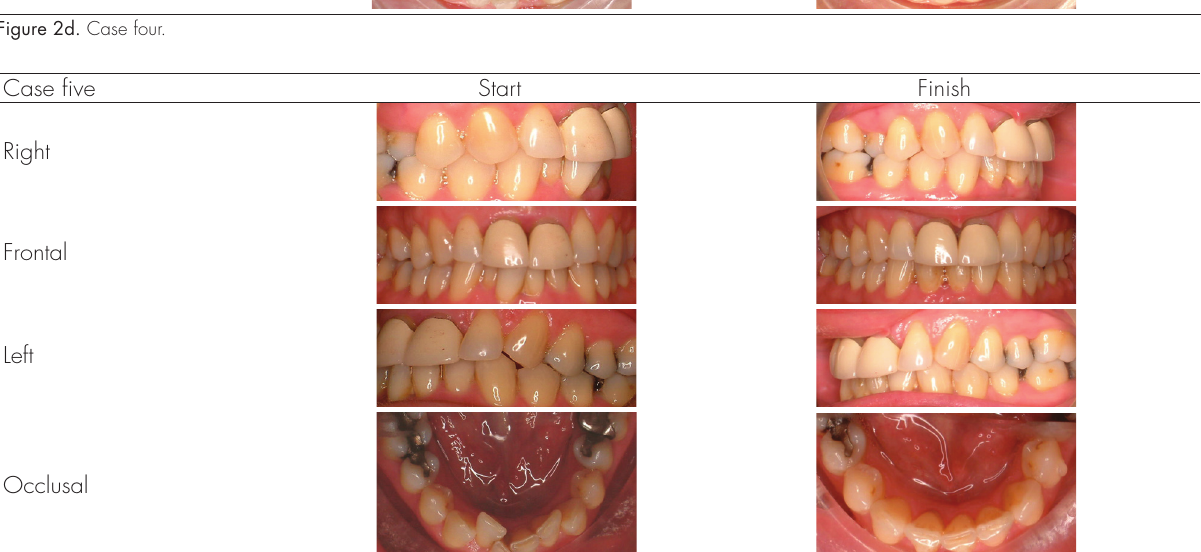
Figure 2d. Case four.